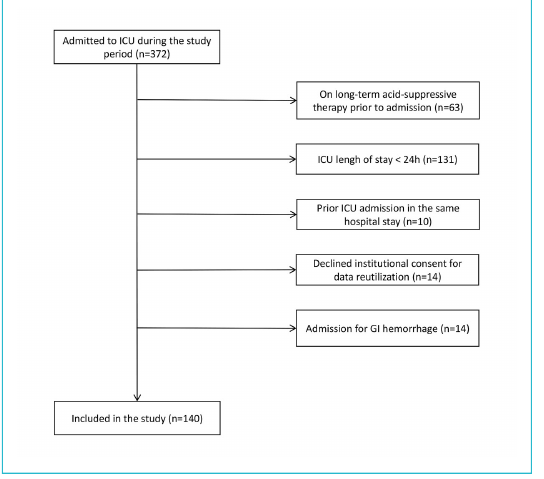
Figure 1: Patients’ inclusion. GI = gastrointestinal; ICU = intensive care unit